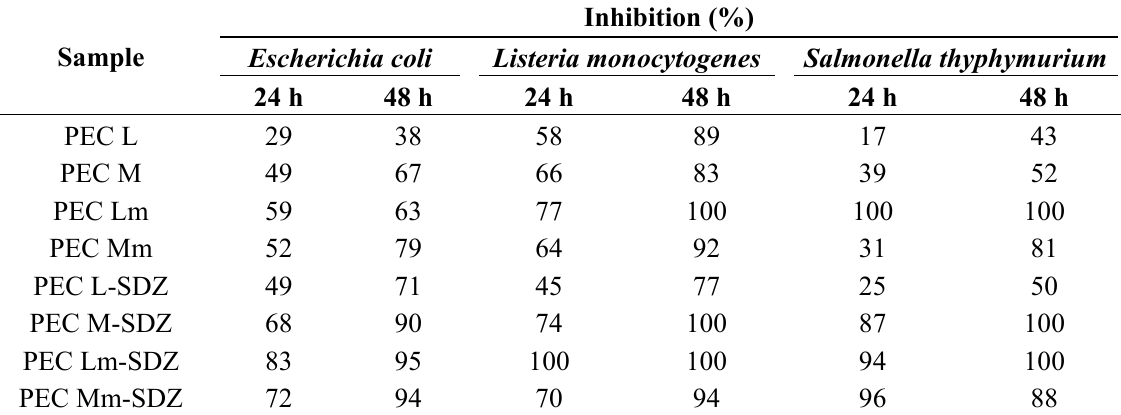
Table 5. Antimicrobial tests results.